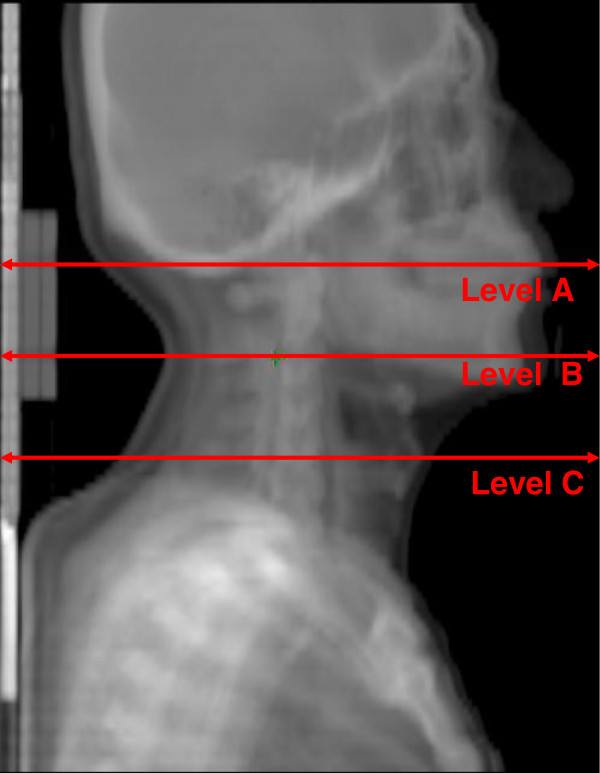
Circumference and thickness measured across three specified sections. Level A is labeled on the mastoid tip, the same section as the junction between the skull base and 1st cervical vertebra. Level B is based on the mandible angle, the same height as the junction between the 2nd to the 3rd cervical vertabra. Level C is drawn from the thyroid notch, the same as the 5th cervical vertebra.